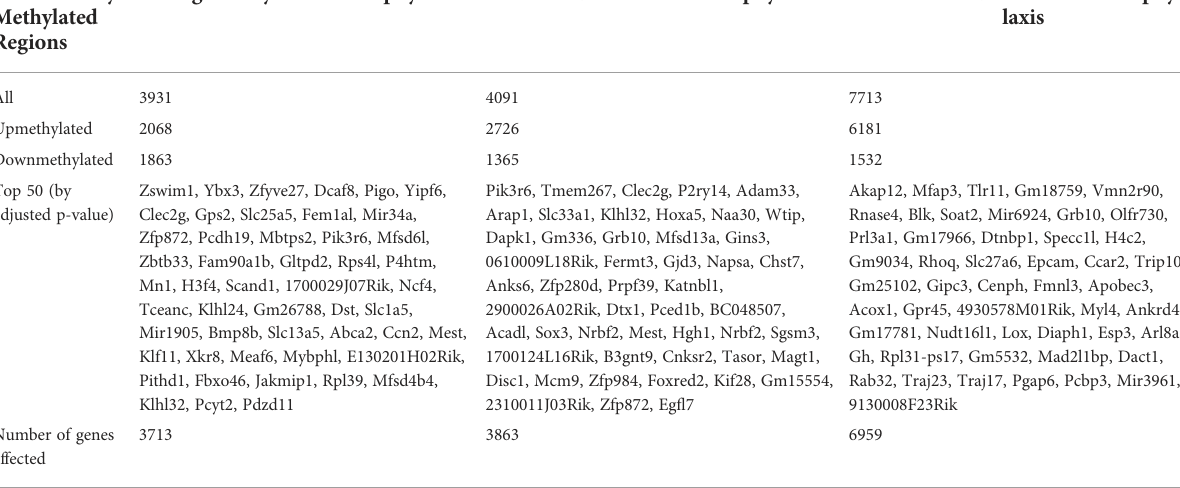
TABLE 1 Number of differentially methylated promoter regions (DMPRs) found in different comparisons against Anaphylactic group. Differentially Methylated